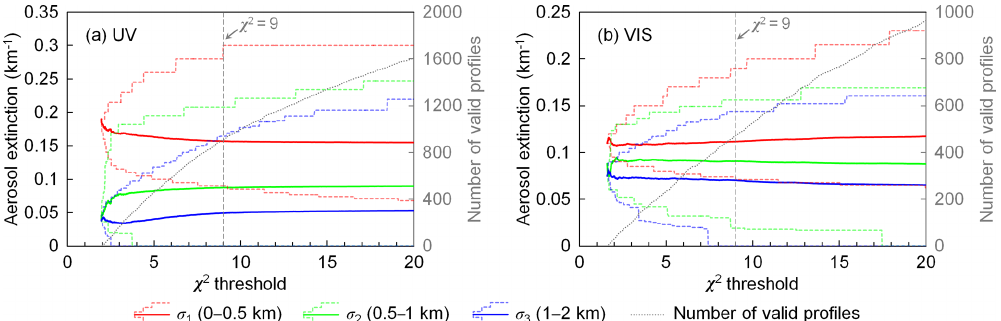
Figure 9. Weighted mean profiles, variation ranges of valid profiles, and number of valid profiles of the (a) UV and (b) VIS bands cor- responding to different χ 2 thresholds, with results of the scanning cycle on 5 July 2015 at ∼ 16:26UTC (SZA ∼ 64 ◦ , RAA ∼ 97 ◦ ). The weighted mean profiles are shown as solid curves which indicate the aerosol extinction coefficients in the three layers ( σ 1 , σ 2 , and σ 3 ). The variation ranges of valid profiles are shown as dashed curves that indicate the variation ranges of σ 1 , σ 2 , and σ 3 . The grey dotted curves indicate the number of valid profiles corresponding to different thresholds of χ 2 . Measured O 4 DSCDs are corrected with the scaling factors listed in Table 6.